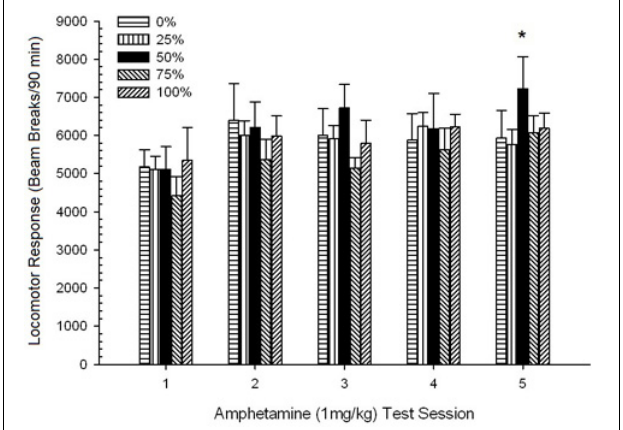
FIGURE 10 | Mean (SE) locomotor response (number of beam breaks in an electronic array per 90min) to 1mg/kg d-amphetamine (i.p.) on 5 weekly sessions in groups of Lewis rats ( n = 8/group) previously exposed to 15 daily conditioning sessions with sucrose reward (10% solution) delivered under 0, 25, 50, 75, or 100% variable schedules. The conditioned stimulus was a light (120s). Group 0 received the same number of rewards as group 100 in the absence of conditioned stimuli. ∗ p < 0 . 05 for mean difference between group 50 and group 0 as well as group 100, based on planned